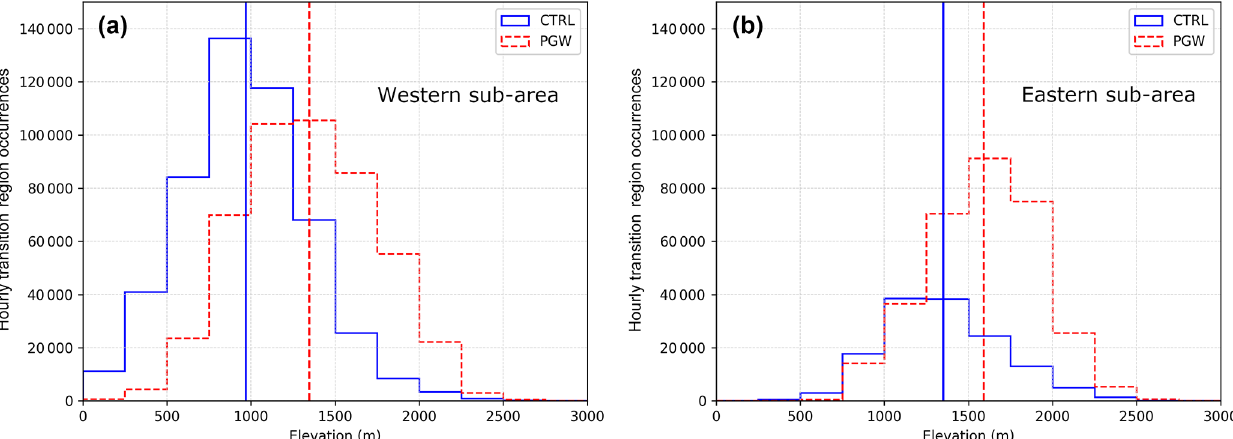
Figure 10. Transition region occurrences for the (a) western and (b) eastern sub-areas binned according to elevation. Vertical solid blue lines and dashed red lines represent the average elevation for CTRL and PGW,